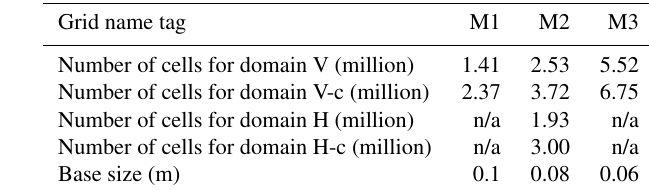
Table 2. Detail of grid sizes for each domain. n/a stands for not applicable.